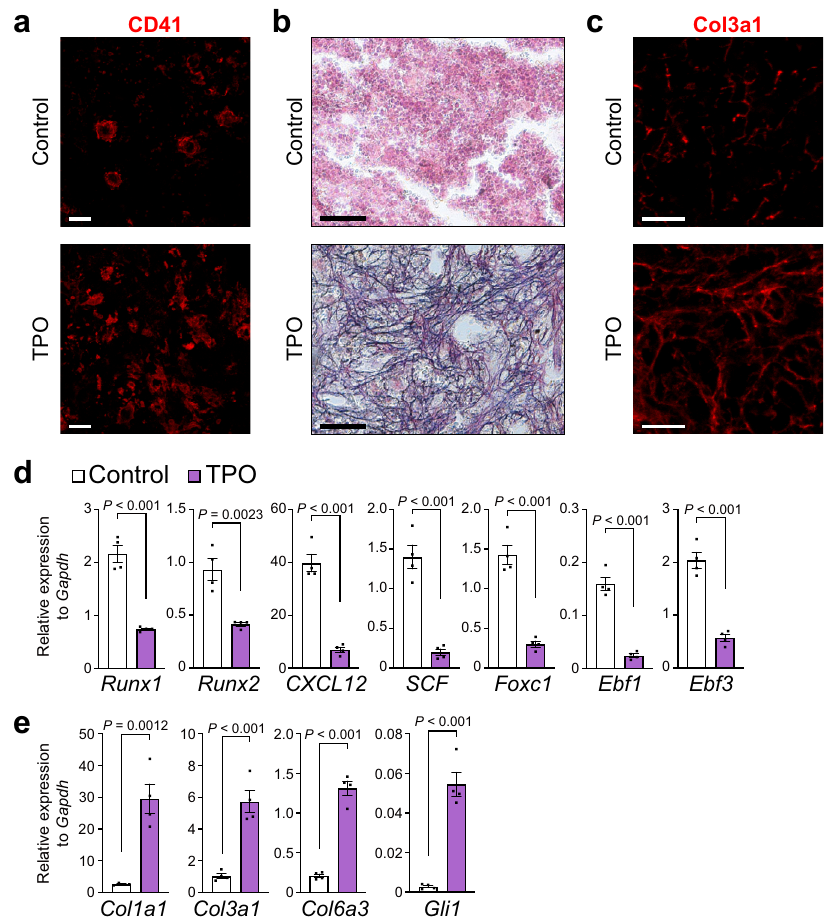
Fig. 6 Expression of Runx1 and Runx2 is decreased in CAR cells in the PMF mouse model. a – e HSPCs infected with retroviruses expressing TPO were transplanted into irradiated mice (TPO). Recipients developing PMF-like disease were analyzed 8 – 9 weeks after transplantation. a – c Immunostaining with antibodies against CD41 ( a ) and Col3a1 ( c ) and silver staining ( b ) of sections from the femur. Bars: 50 μ m ( a , c ) and 20 μ m ( b ). d , e Relative mRNA expression levels of Runx1 , Runx2 , CXCL12 , SCF , Foxc1 , Ebf1 , Ebf3 ( d ), Col1a1 , Col3a1 , Col6a3 , and Gli1 ( e ) in sorted CAR cells ( n = 4 mice per group). All error bars represent SD of the mean ( d , e ). Statistical signi fi cance was calculated using the two-tailed unpaired Student ’ s t -test. Source data are provided as a Source Data fi